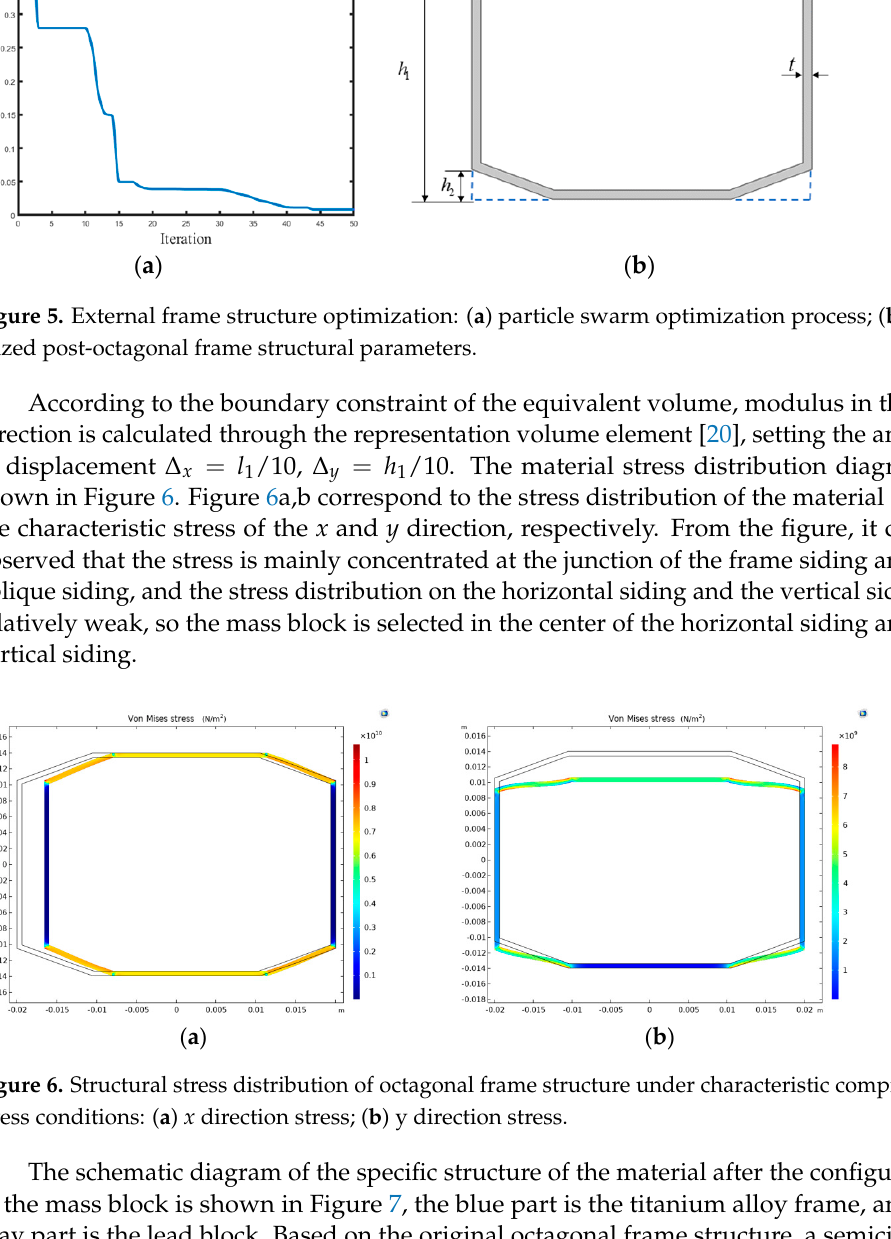
Figure 7. Frame material structure diagram with counterweight blocks.